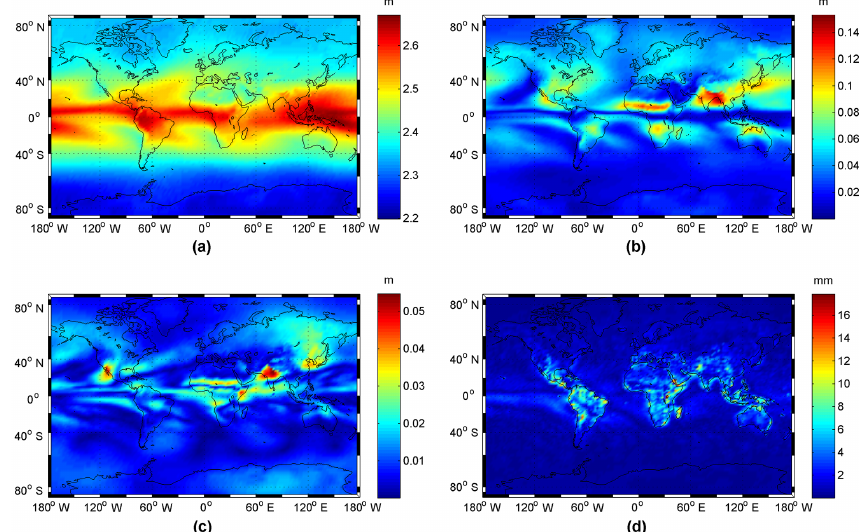
Figure 3. The global distribution of the annual mean ZTD on MSL (a) , the annual variation amplitude (b) , the semiannual variation ampli- tude (c) , and the diurnal variation amplitude (d) .